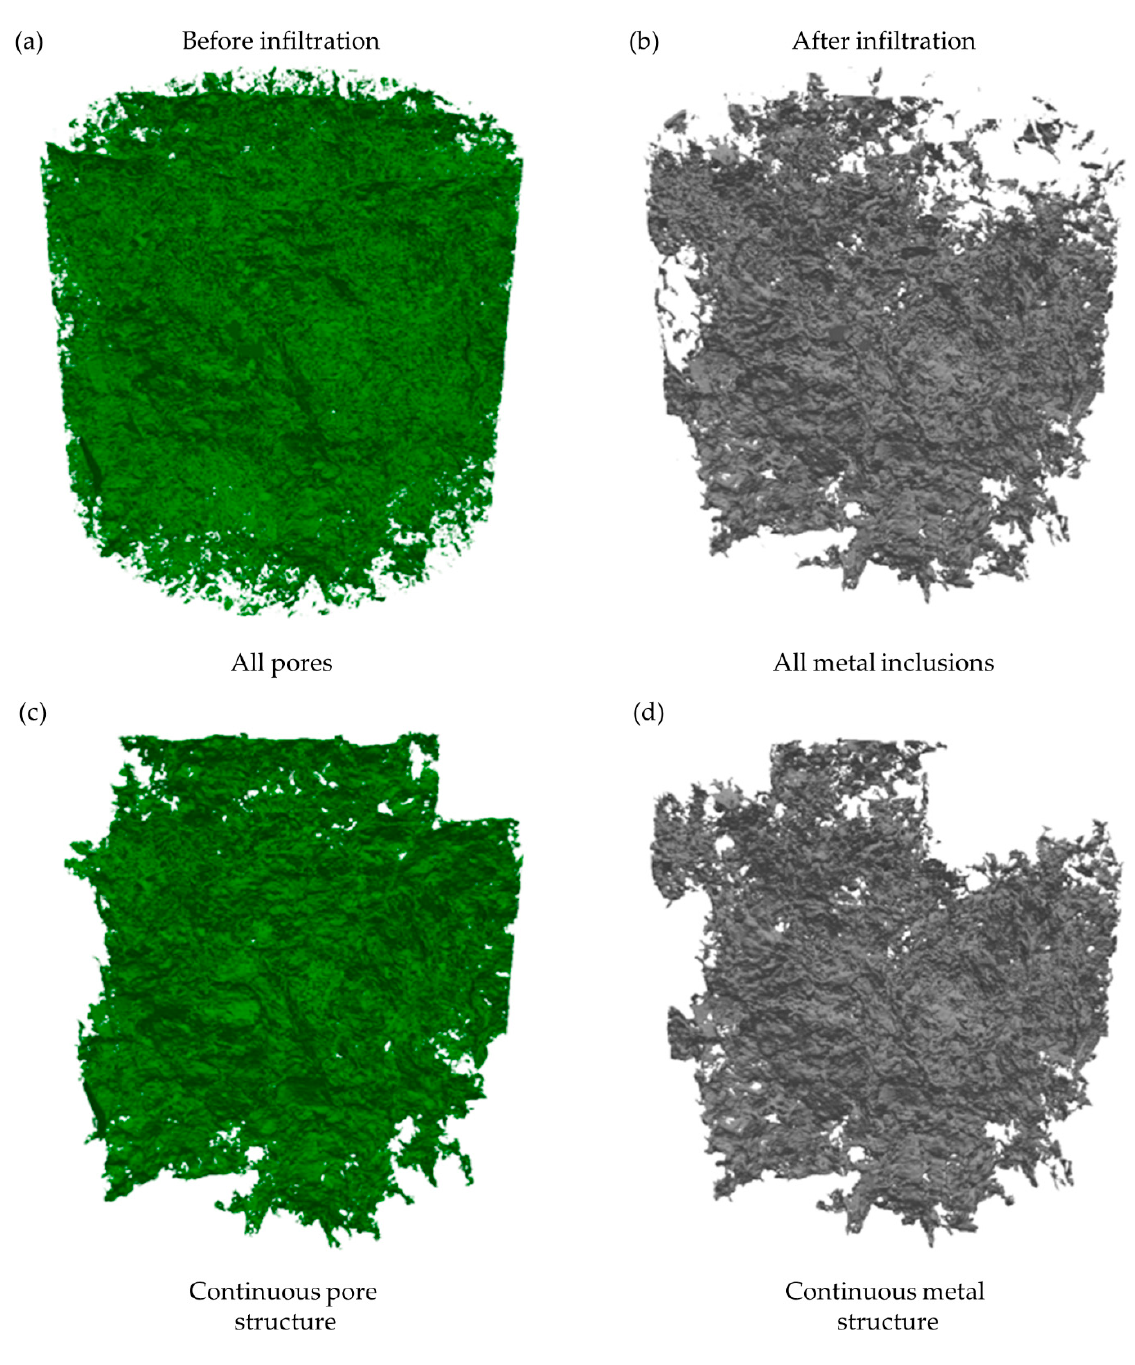
Figure 8. Visualization of ( a ) all pores in the initial sample, ( b ) all metallic inclusions in the sample after the test, ( c ) continuous pore structure, and ( d ) continuous metal structure. Table 2. Volume fraction, standard deviation ( σ ), and volume (V) of pores and metal inclusions.